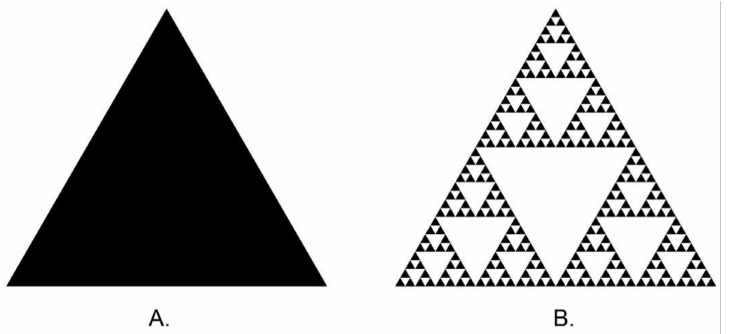
Figure 1. ( A ) Triangle (fractal dimension = 2), ( B ) Sierpinski triangle (fractal dimension ≈ 1.585) (Gen- erated by https://codinglab.huostravelblog.com/math/fractal-generator/ Accessed on 1 October